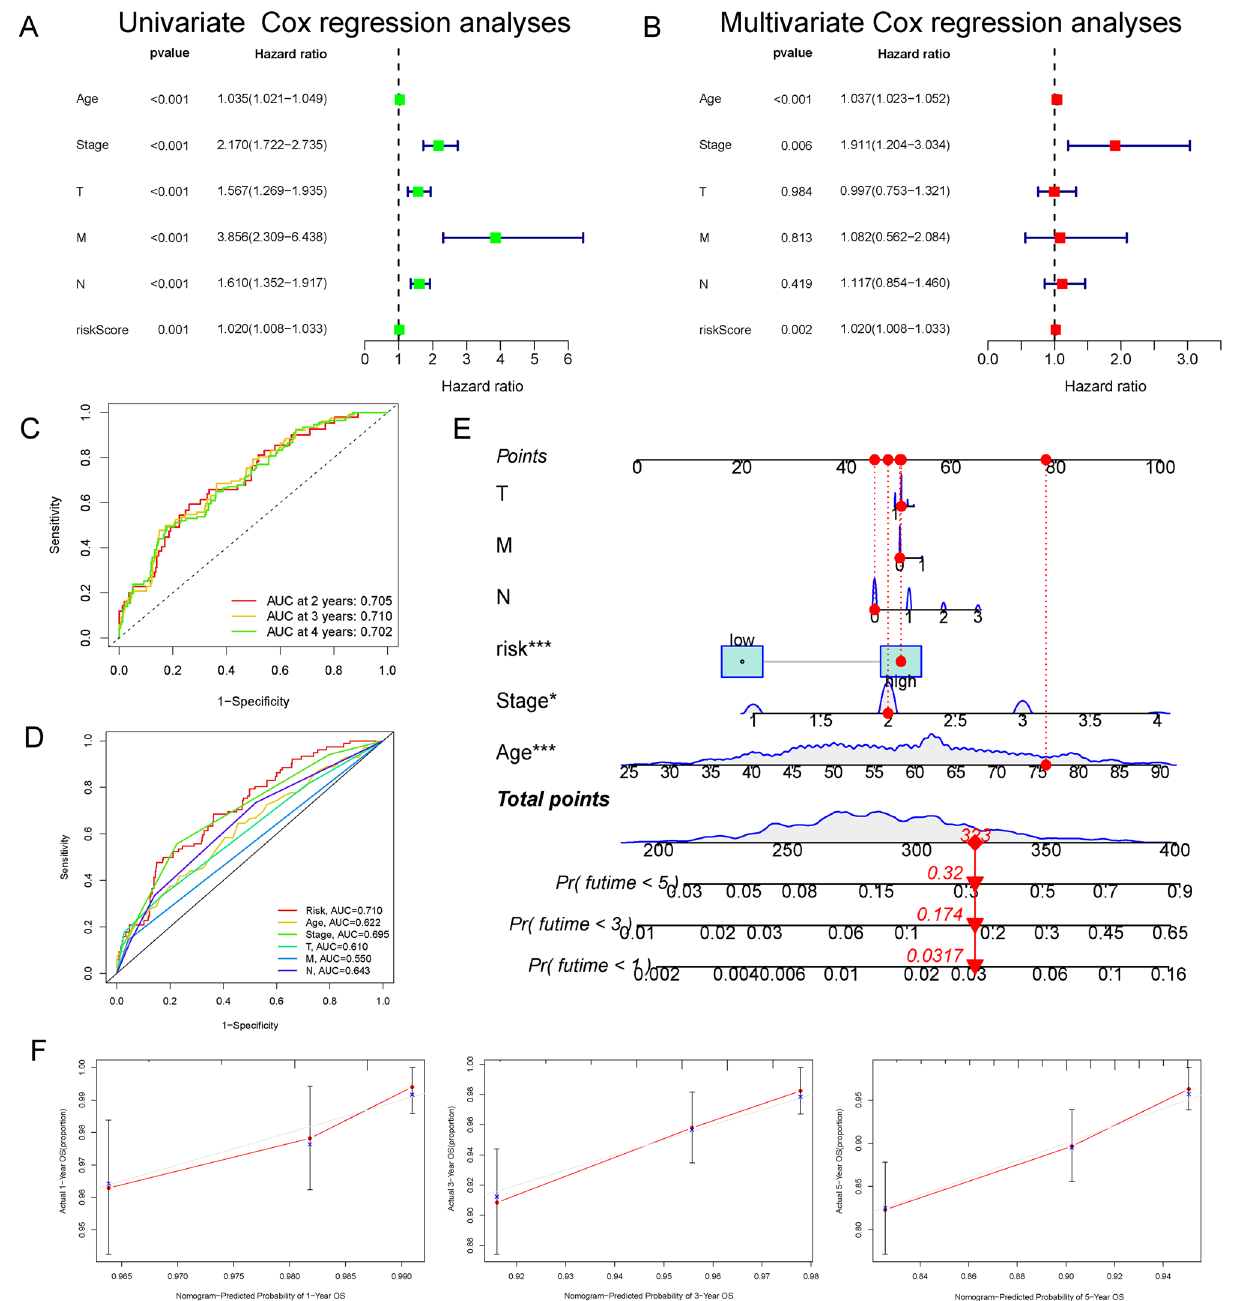
Figure 3. Validating the immune-related predictive model in the training cohort of breast cancer (BC) patients. Univariate ( A ) and multivariate ( B ) Cox regression analyses determined that the risk score was independently associated with poor overall survival (OS) in BC. ( C ) The receiver operating characteristic (ROC) curves of the risk model at 2-, 3- and 4-year. ( D ) The area under the curve (AUC) of the risk score for predicting that 3-year OS of BC patients was higher than that of age, clinical stage, and tumour-node-metastasis (TNM) stage. ( E ) All independent prognostic factors, including the risk score, were incorporated into the model to delineate a nomogram for predicting the 1-, 3- and 5-year individual survival rates of BC patients. ( F ) Based on the consistency between the observed and predicted values, the nomogram calibration plot of the training cohort was established. BC breast cancer, OS overall survival, ROC receiver operating characteristic, AUC area under the curve, TNM